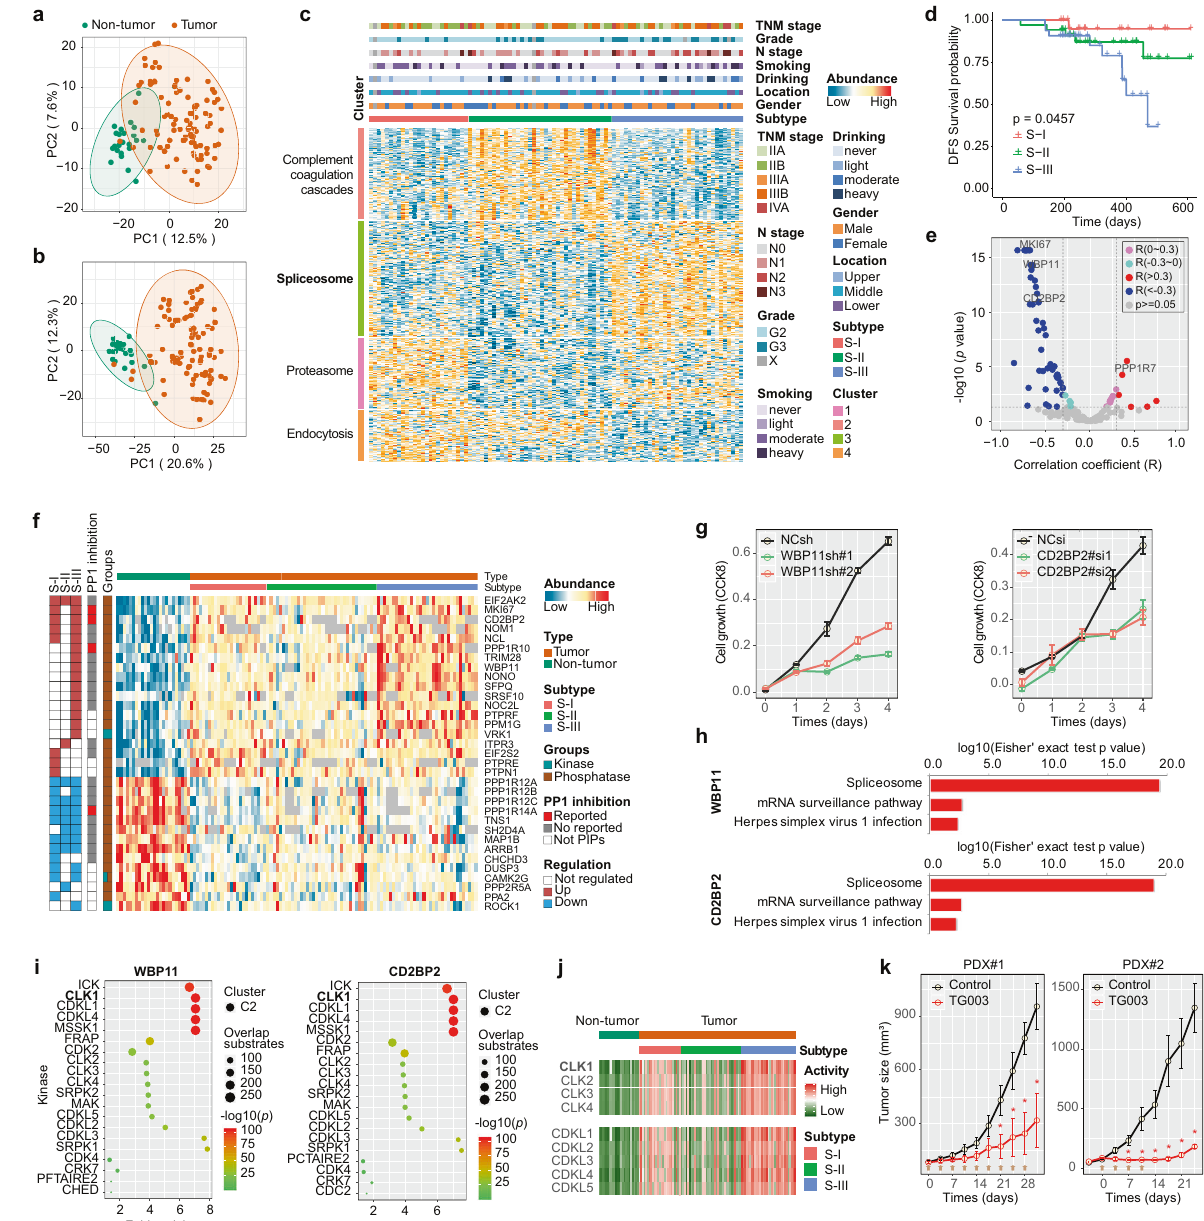
Fig. 1 a , b PCA scatter plots of proteomic ( a ) and phosphoproteomic ( b ) datasets in 94 tumors and 24 non-tumor tissues. c Consensus clustering analysis of proteomic pro fi ling identi fi es 3 proteomic subtypes:S-I (red), S-II (green), and S-III (blue). The associations of proteomic subtypes with clinical characteristics (TNM stage, grade, age, drinking, smoking, etc.) are annotated in the upper panel. Top two KEGG pathways related to these cluster signature proteins are denoted on the left, and annotated according to the KEGG pathway enrichment analysis (detailed in Supplementary Table S3). d Kaplan-Meier curves of disease-free survival (DFS) for each proteomic subtype in our cohort. e Volcano plot of the correlation coef fi cient (R) between phosphatase or phosphatase interacting protein (PIP) abundance with inferred phosphatase activity. f Differentially expressed phosphatase or phosphatase-PIPs and kinase pro fi les in three subtypes of ESCC and non-tumor tissues. g Effect of WBP11 (left) and CD2BP2 (right) knockdown on ESCC cell proliferation. h The top 3 KEGG pathways were enriched by the differentially expressed phosphorylation interactors (DEPIs) of WBP11 (top) and CD2BP2 (bottom). i Top 20 kinases in the pairing relationship analysis (PRA) of two PP1 PIPs, WBP11 (left) and CD2BP2 (right) opposed. The shape (dot or square) represents the cluster to which the kinase belonged. The size of dot or square represents the mapping number of proteins, the color of dot or square represents the signi fi cance. j Differentially inferred activity of CLKs and CDKLs pro fi les in three subtypes of ESCC and non-tumor tissues. k The average volume of tumors (± s.e.m.) of ESCC PDX model #1 and #2 treated with control (PBS) and TG003 at the indicated times. Brown arrows indicated the times of drug treatment The phosphatases with corresponding kinases well coordinate to associated differentially expressed phosphorylation interactors ensure phosphorylation homeostasis of proteins. Here, the corre- (DEPIs) were generated (Supplementary Fig. S7d-e), and the top sponding kinases of each phosphatase were analyzed by paired pathway enriched by the DEPIs of PPP1C-CD2BP2 and PPP1C- relationship analysis (PRA). As shown in Fig. 1i, the substrates of WBP11 both was the spliceosome pathway (Fig. 1h). Signal Transduction and Targeted Therapy (2021)